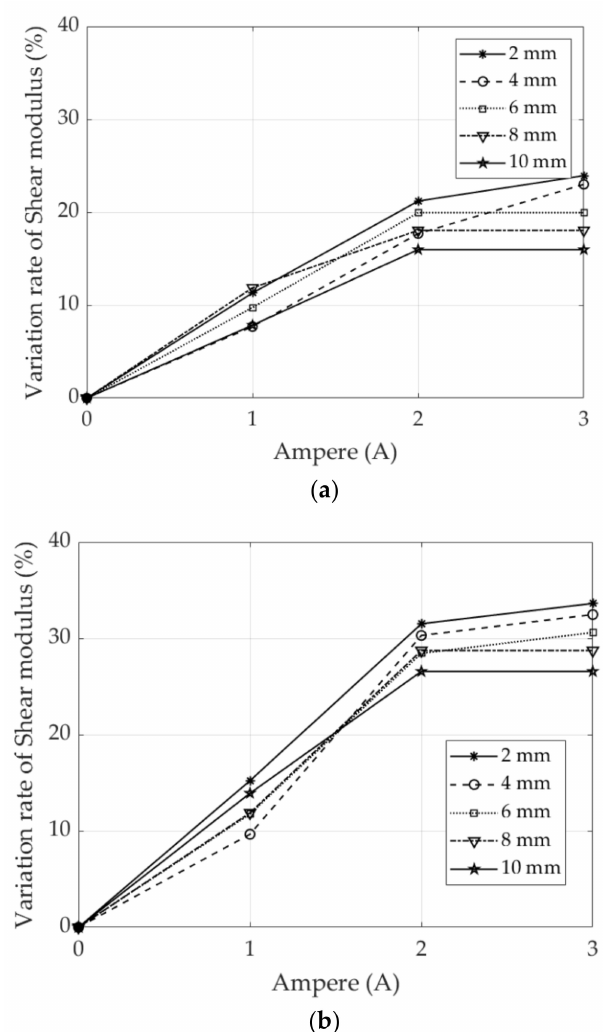
Figure 11. Variation rate of shear modulus isotropic / anisotropic MRE. ( a ) Isotropic MRE, ( b ) Anisotropic